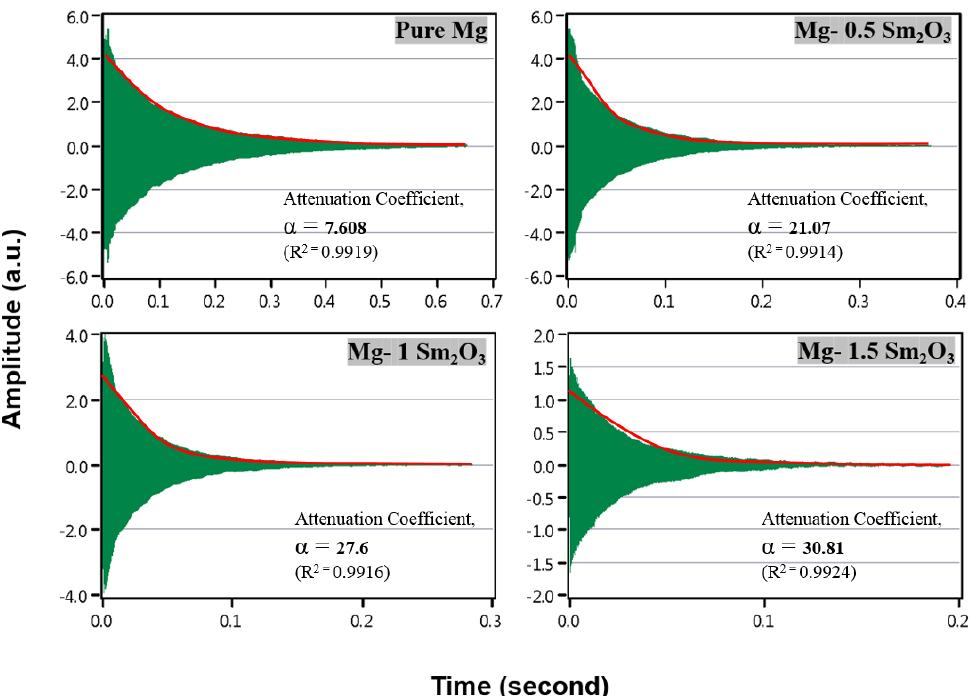
Figure 5. Damping characteristics of Mg and its nanocomposite samples. Table 5. Elastic modulus and damping characteristics of Mg-Sm 2 O 3 nanocomposites.